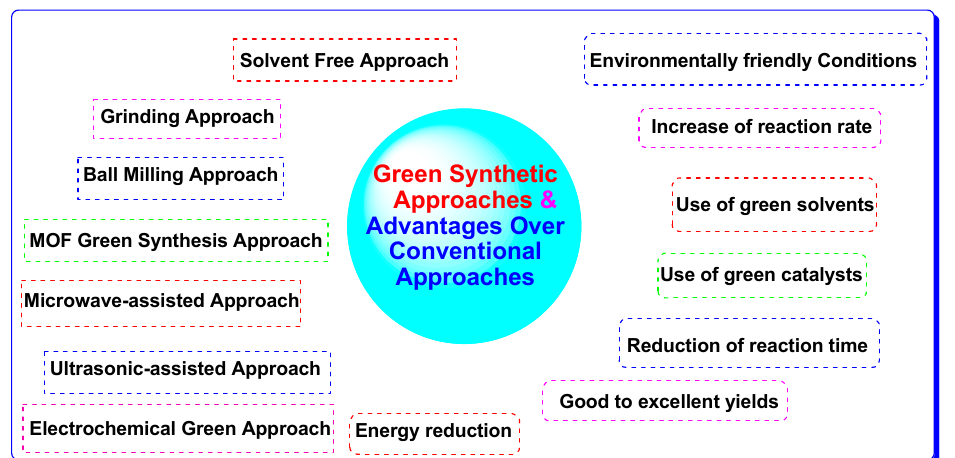
Figure 2. Green approaches and their advantages over conventional approaches.